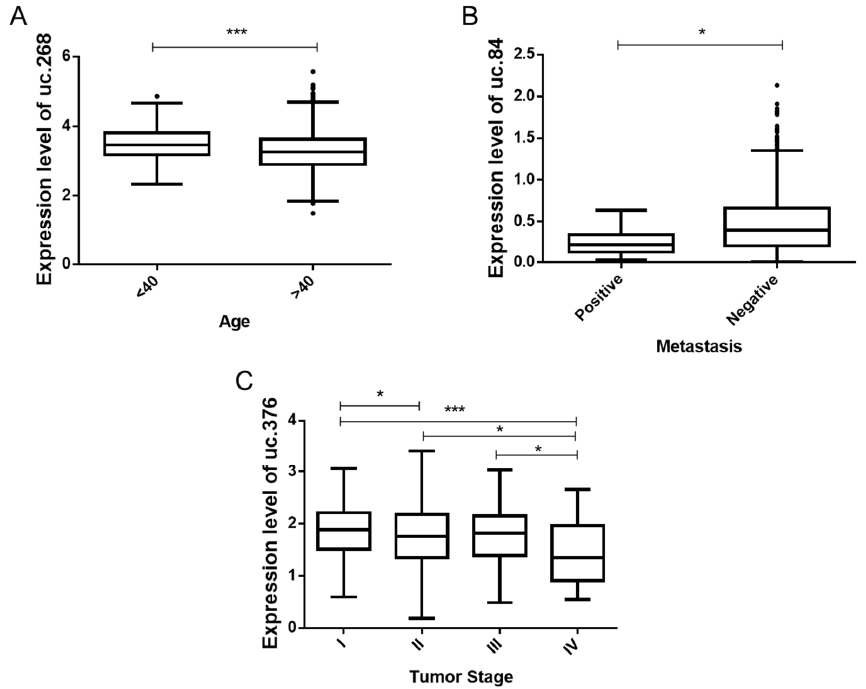
Figure 5. Comparison of T-UCRs expression to clinicopathological data from TCGA data. ( A ) Differential expression level of uc.268 between the patients’ ages ( p < 0.001). ( B ) Significant down-relative expression of uc.84 patients with metastasis compared to patients negative for metastasis ( p < 0.05). ( C ) Significant reduction in uc.376 ( p < 0.05) between tumor stage I, II, III, and IV. * p < 0.05, and *** p < 0.001. Table 2. Summary of univariate and multivariate Cox regression analysis of al T-UCRs in overall patients